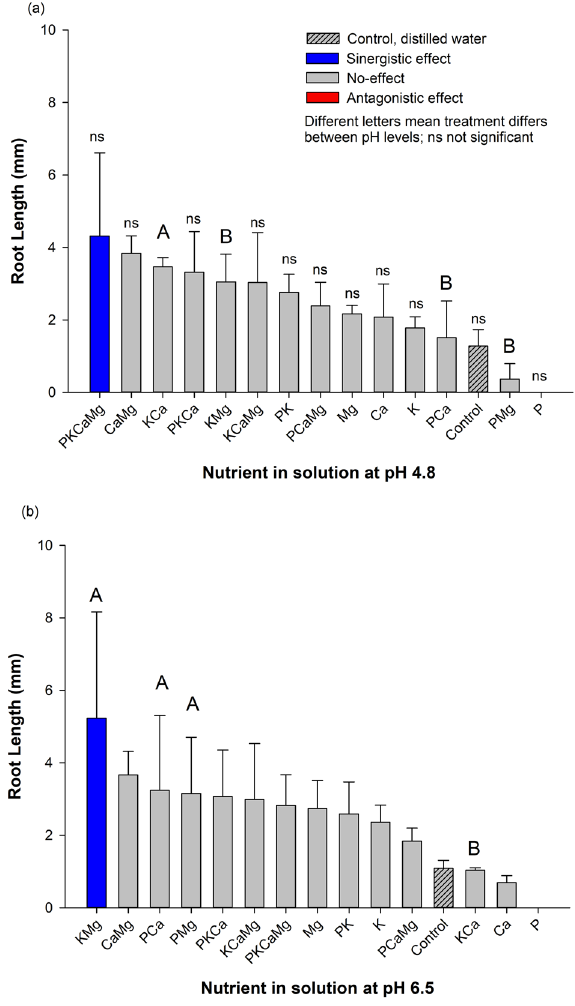
Figure 4. Root length (RL) of Conyza canadensis in response to the nutrients (alone or in combination) under solutions at pH 4.8 ( a ) and at pH 6.5 ( b ). Bars with the different colours, comparing means among treatments, are significantly different, according to the Tukey’ test (p < 0.05). Different letters represent a statistical difference for the same treatment between the two pH tested while ns represents not significant; The results in the Bars represent means, while error bar marks represent standard deviation ( n = 4) from the mean